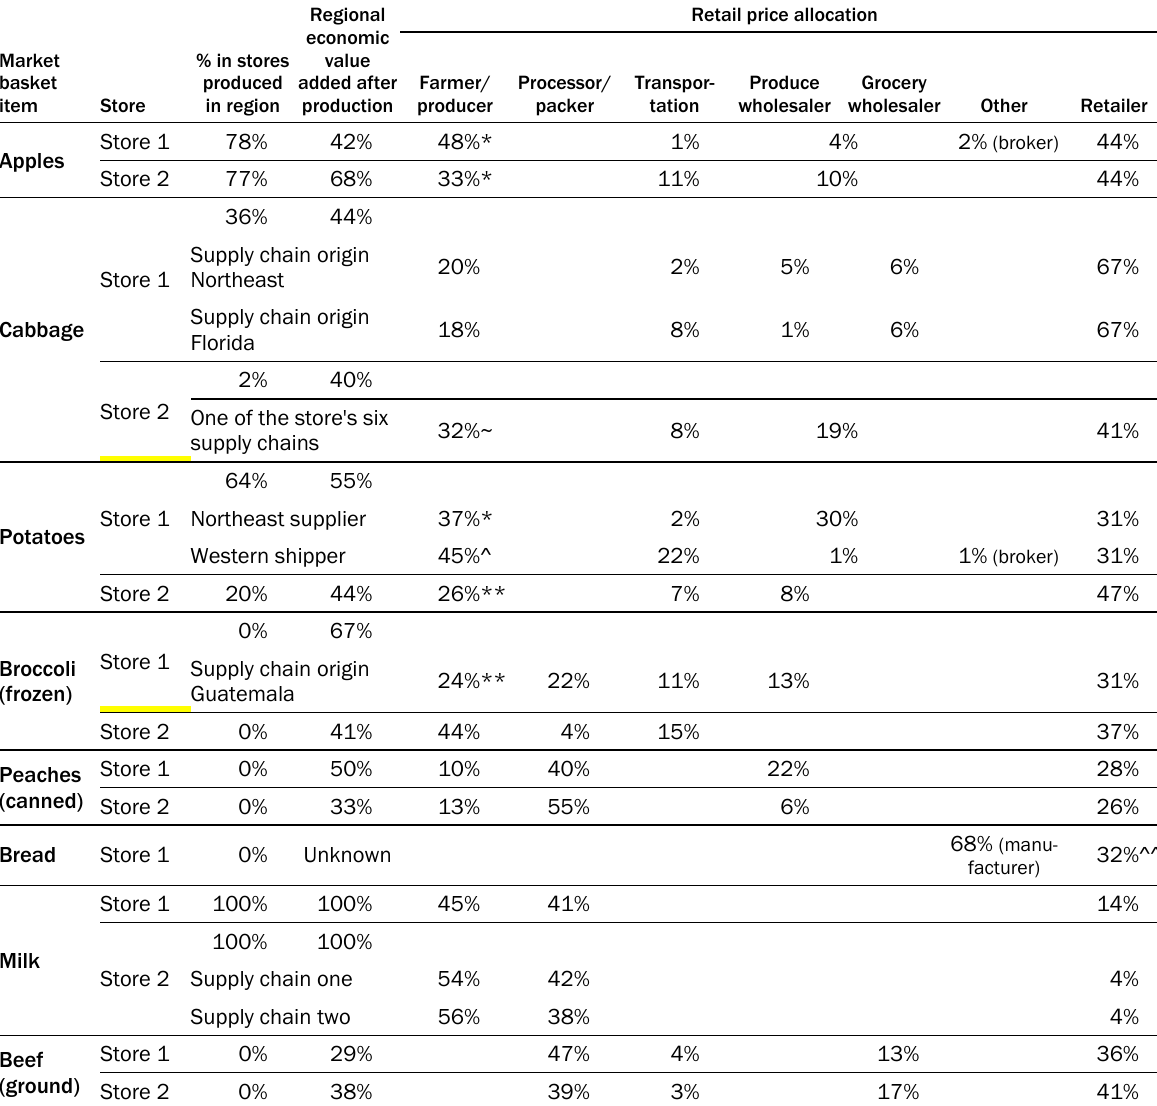
Table 3. Supply Chain Analysis of Market Basket